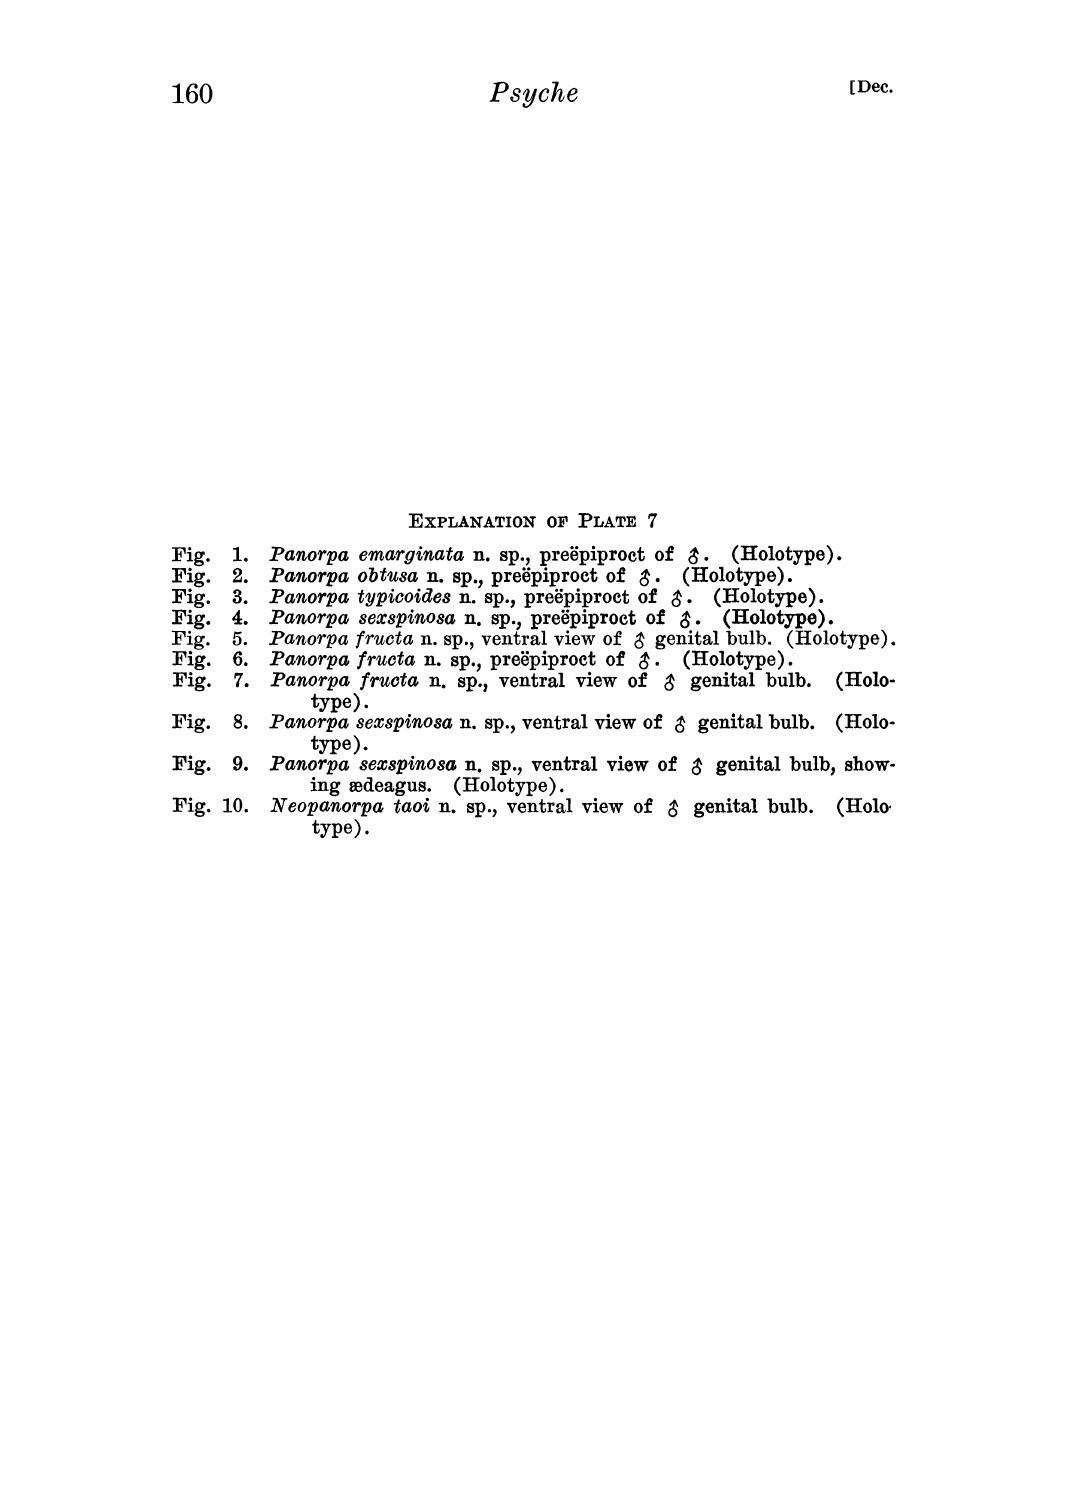
EXPLAIATI01 OF PLATE Panorpa emarginata n. sp., prepiproct of 8. (Holotype). Panorpa obtusa n. sp., prepiproct of 8. (Holotype). Panorpa typicoides n. sp., prepiproct of 8. (Holotype). Panorpa sexspinosa n. sp., prepiproct of 8. (Holotype). tanorpa fructa n. sp., ventral view of 3 genital bulb. (Holotype). Fig. 5. Panorpa fruvta n. sp., prepiproct of 8. (Holotype). Fig. 6. Panorpa l’ruva n. sp, ventral view of 3 genital bulb. (Holo- lig. 7.